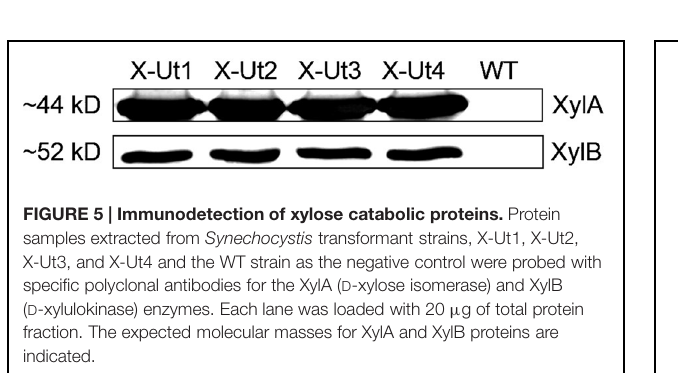
FIGURE 4 | Transcription evaluation of xylose-specific genes. (A) Primers upstream and downstream of the xylose transporter genes xylE (A1–A2), galP (B1–B2), and glf (C1–C2) were used (Figure 2A) to examine whether these genes were transcribed in the corresponding strains represented as ‘Test.’ In the presence of the templates, primers A1–A2, B1–B2, and C1–C2 produced products of ∼ 1.48, ∼ 1.40, and ∼ 1.42 kb in length, respectively. (B) Primers upstream and downstream of the xylose catabolic genes xylAB (E1–E2) were used (Figure 2B) to evaluate the transcription of the genes in the corresponding strains represented as ‘Test.’ In the presence of the templates, primers E1–E2 produced products of ∼ 2.85 kb. For the positive control ( + ), transcription of petA was examined using a gene-specific primer pair. The primer set produced a ∼ 0.99-kb product from cDNA templates of the transformants. For the negative control ( − ), amplification of heterologous genes from the corresponding RNA samples was evaluated using the gene-specific primer pairs. The primer pairs failed to generate any PCR product, indicating the absence of DNA contamination in the RNA samples.